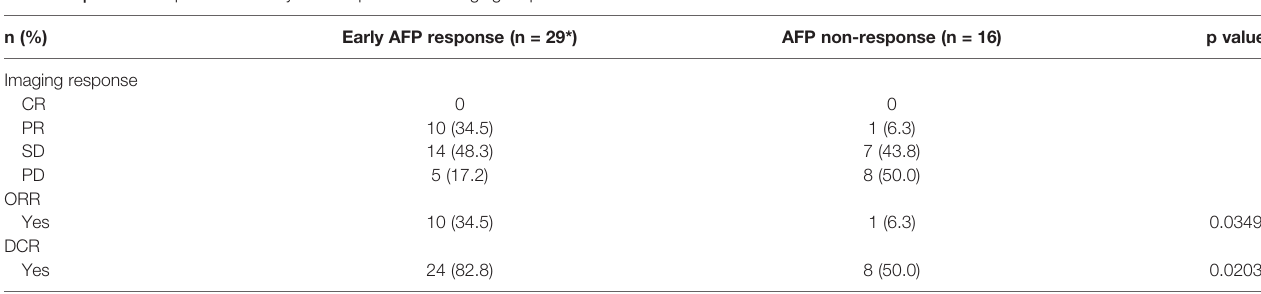
TABLE 2 | Relationship between early AFP response and imaging